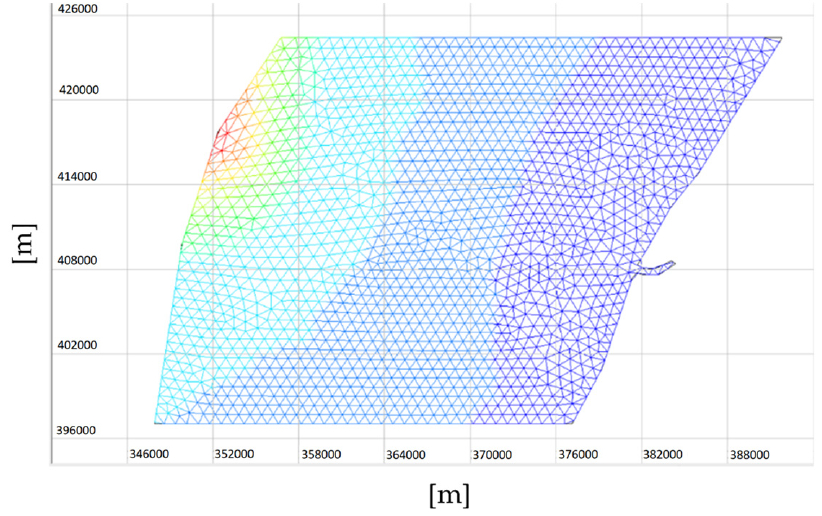
Figure 3. Mesh used of the study area: regular grid of approximately 25 m resolution.